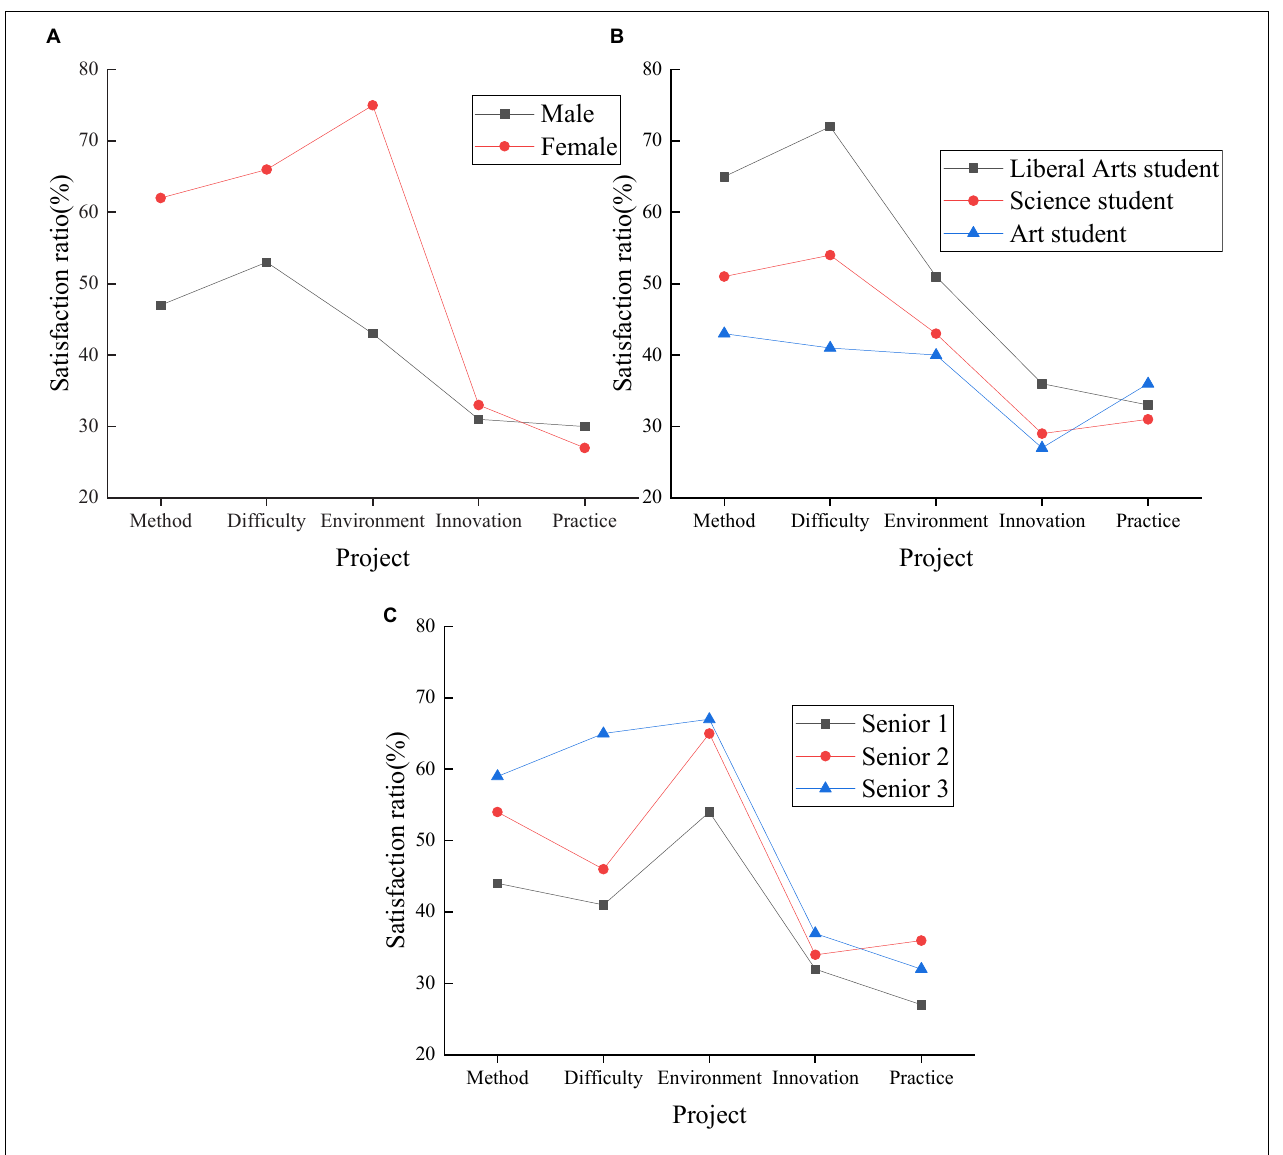
FIGURE 3 | High school students’ satisfaction with traditional English grammar teaching (Panel A: gender classification, Panel B: learning direction classification, Panel C: grade